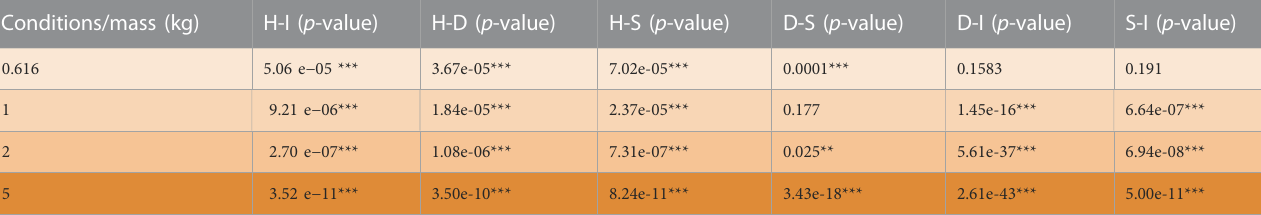
TABLE 3 Result of t-test analysis for physical work between different conditions and same masses (D: direct-weight, H: haptic, S: speed-control, I: isomorphic). Conditions/mass